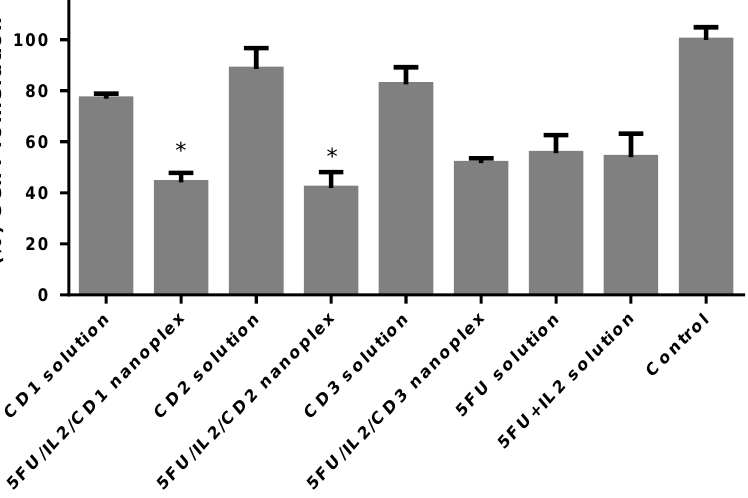
Figure 3. Cell viability analysis results after treatment was applied to the 3D CT-26 tumor model.